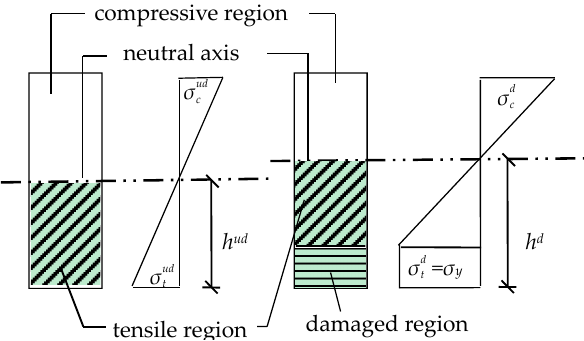
Figure 3. Damage development with the increase of neutral axis depth (NAD) in a rectangular beam.